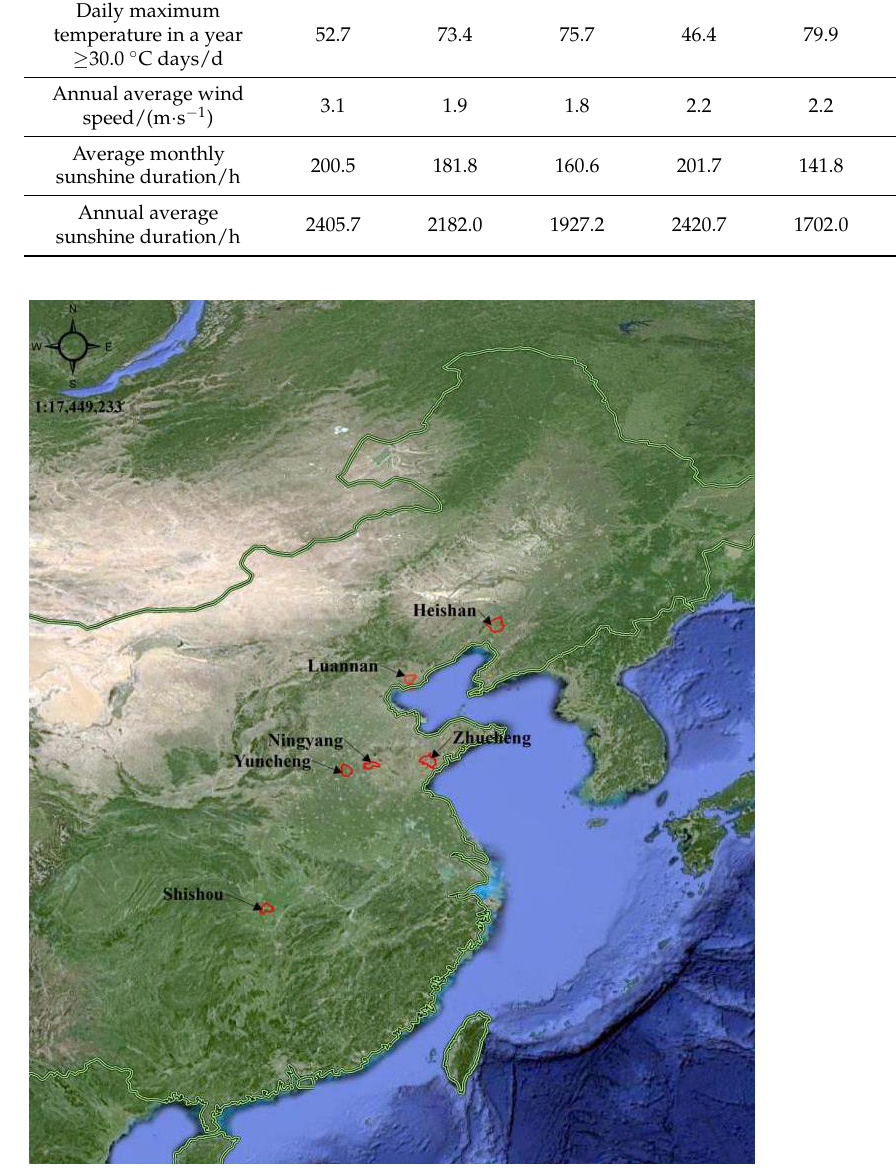
Figure 1. Locations of test sites.